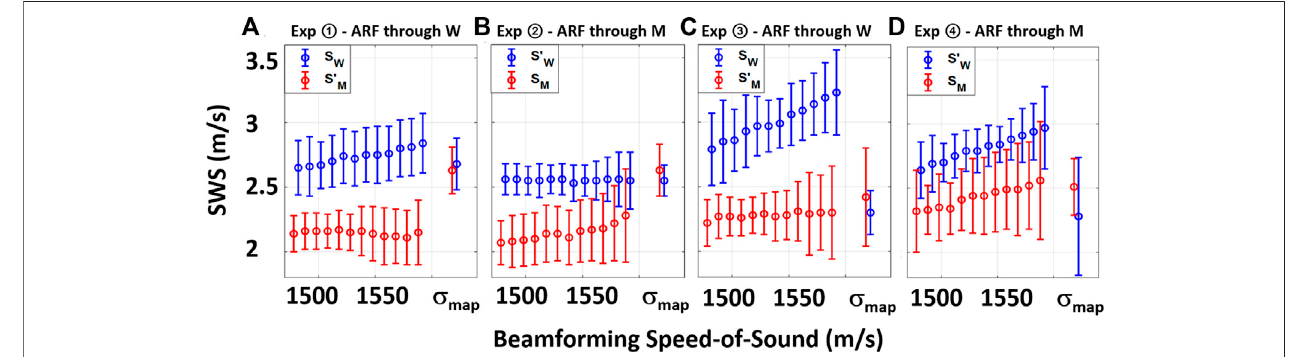
FIGURE 4 | Visual summary of Table1 with SWS values obtained from the two ROIs in each experimental setting when beamformed with constant SoS values and σ map